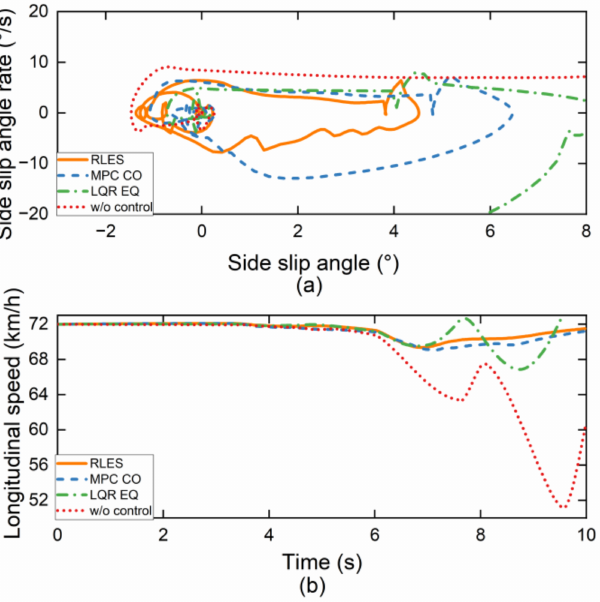
Figure 10. Simulation results under joint road. ( a ) Phase trajectory portrait; ( b ) longitudinal velocity.